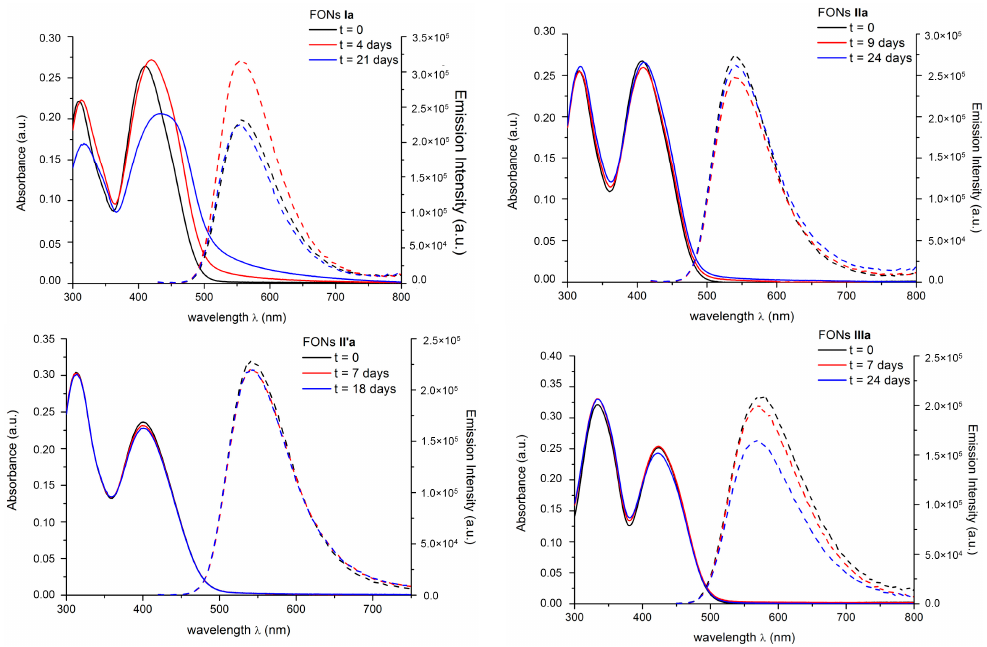
Figure 8 . Monitoring of the evolution of the absorption and emission features of FONs made from dyes I – IIIa in water over time.